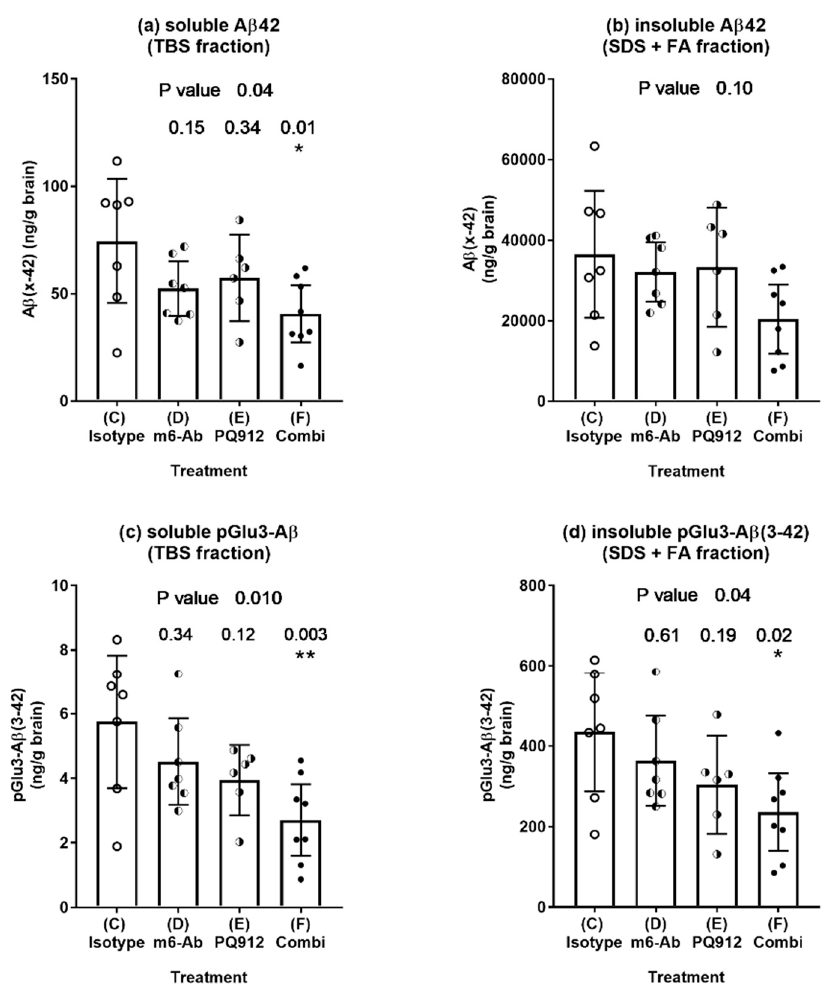
Figure 1. A β levels (ELISA) in brain homogenates of hAPPsl × hQC mice after treatment with PQ912 (Varoglutamstat), a monoclonal pGlu-A β antibody (m6-Ab) or in combination for 16 weeks. Concentration of A β (x–42) ( a , b ) and pGlu3-A β (3–42) ( c , d ) in soluble ( a , c ) and insoluble ( b , d ) brain fractions of 12-months-old hAPPsl × hQC mice after 16 weeks of treatment. Dots represent individual levels. Bars and whiskers represent mean ± 95% confidence interval (CI). ANOVA p -values are given on top of the graphs. Numbers above the bars represent adjusted p -values of Dunnett’s post-hoc comparison with the isotype control (*— p < 0.05, **— p < 0.01). There is a nominal decrease of total A β 42 and pGlu3-A β 42 by the single treatments. The effect of the combination is stronger compared to the single treatment and becomes significant for pGlu3-A β in both fractions and for A β 42 in the TBS fraction.